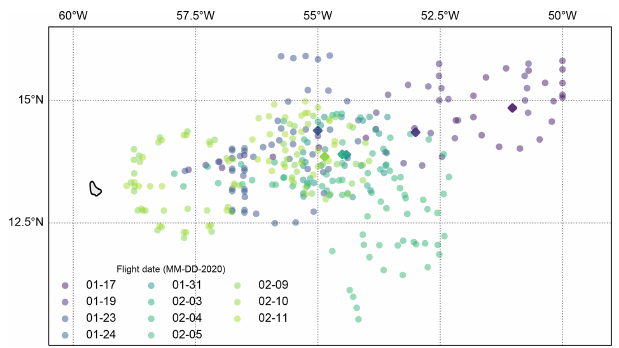
Figure 4. Location of dropsondes deployed during ATOMIC. Most circles (see Table 1) were centered on the position of the R/V Ronald H. Brown ; the ship’s position at the start of the circle is shown with a diamond.